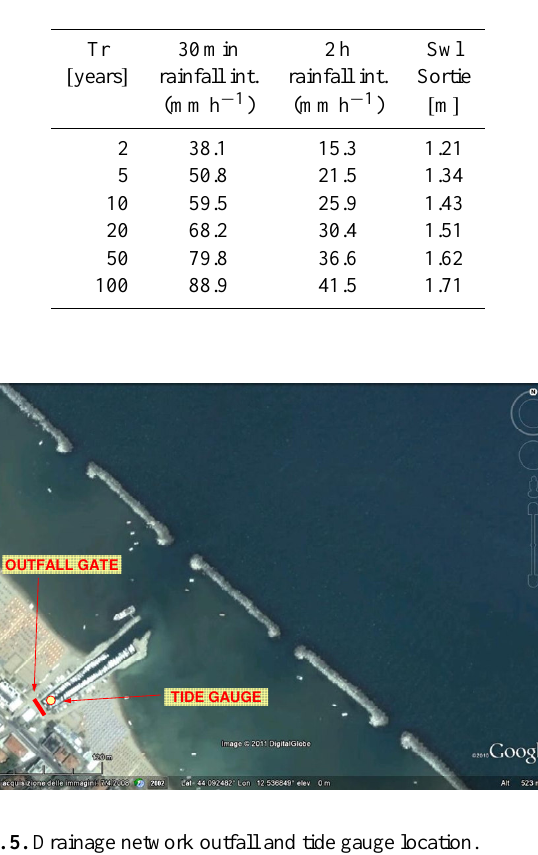
Table 1. Extreme values for rainfall intensity and sea water level at Sortie, as a function of return period.